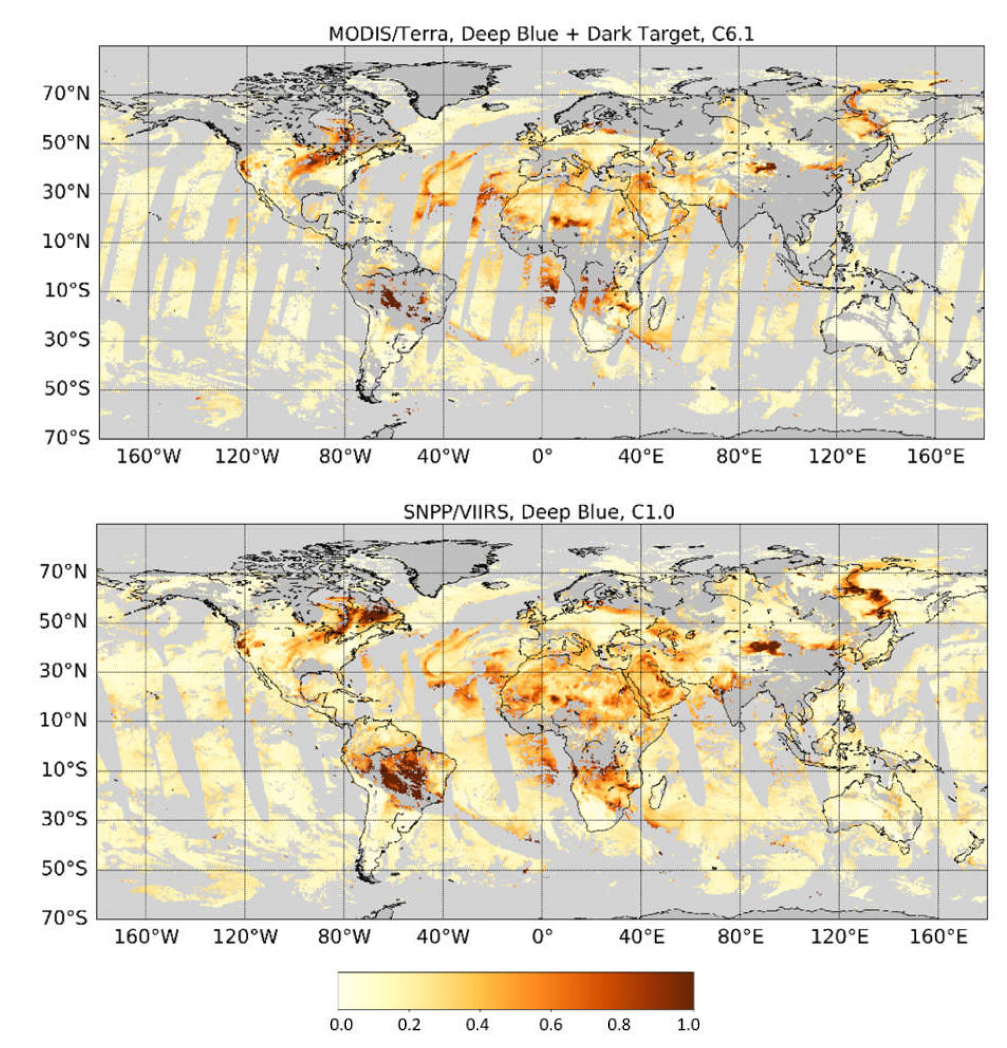
Figure 6. AOD derived from MODIS-Terra (top) and VIIRS (bottom) for 21 September 2020. The MODIS AOD is based on the collection 6.1 merged Deep Blue/Dark Target retrieval. The VIIRS AOD is based on the Deep Blue/SOAR